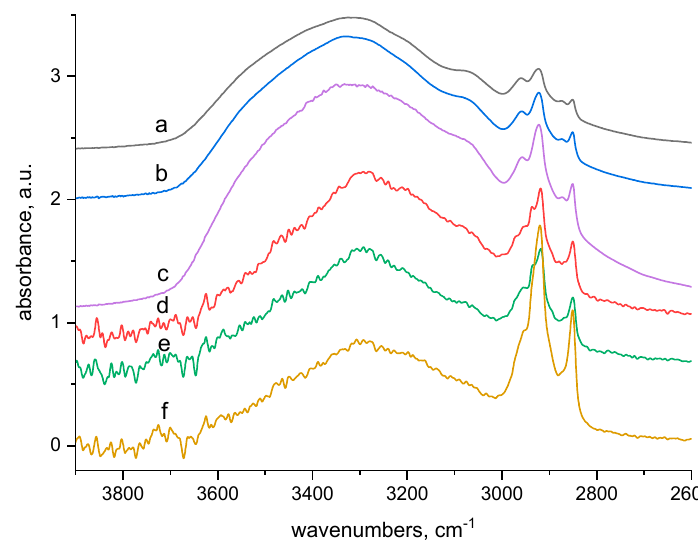
Figure 5. Comparison of the transmission and ATR spectra of wool with absorbed doses 0 kGy, 24 kGy and 165 kGy respectively after contact with 100 mmol·dm − 3 CuSO 4 solution (region 3800–2600 cm − 1 ); from top to bottom: (a), (b) and (c)—transmission spectra of 0 kGy, 24 kGy and 165 kGy dosed samples; (d), (e) and (f)—ATR spectra of 0 kGy, 24 kGy and 165 kGy dosed samples.